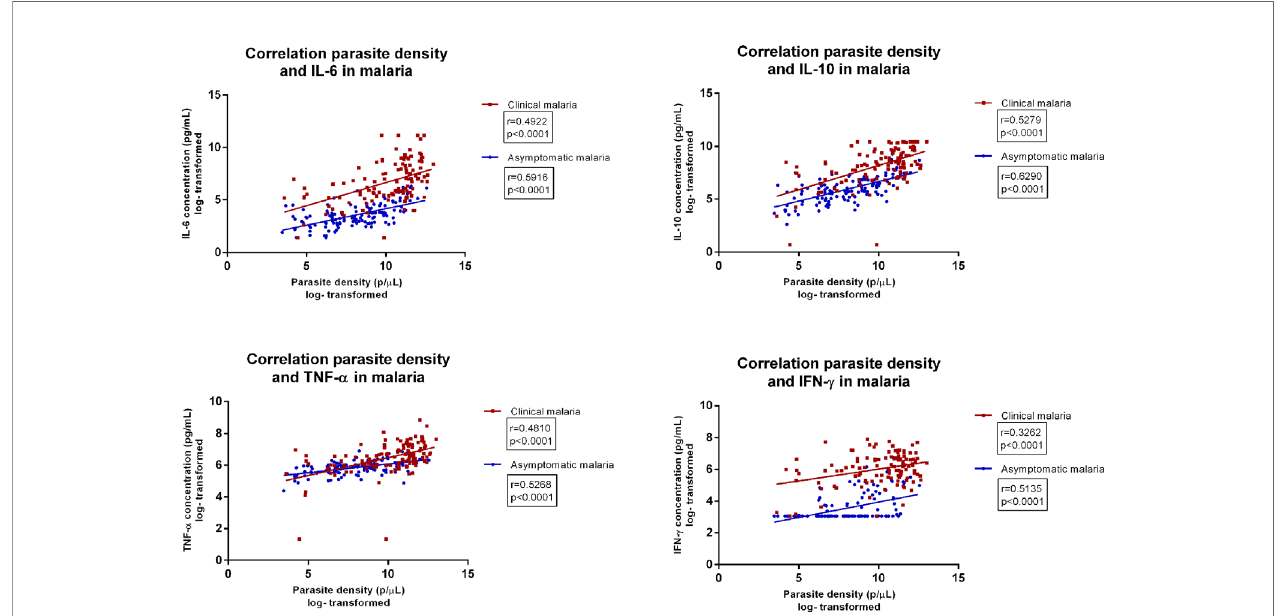
FIGURE 2 | Correlation between parasite density and concentrations of various circulating cytokines in asymptomatic malaria and clinical malaria, among patients below the age of fi ve. Legend | parasite densities reported in parasites/µL. Cytokine concentrations are reported in pg/mL.